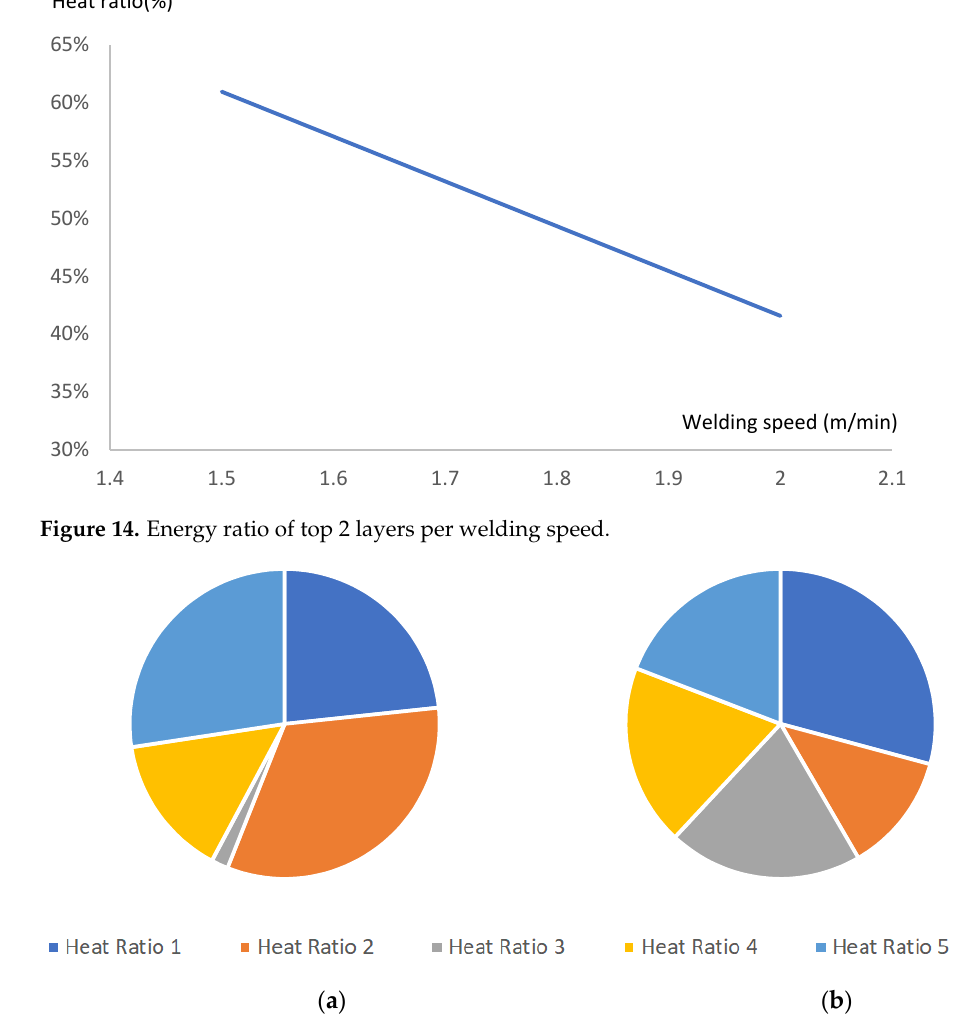
Figure 15. Energy concentration by layer per welding speed. ( a ) 1.5 m/min; ( b ) 2.0 m/min